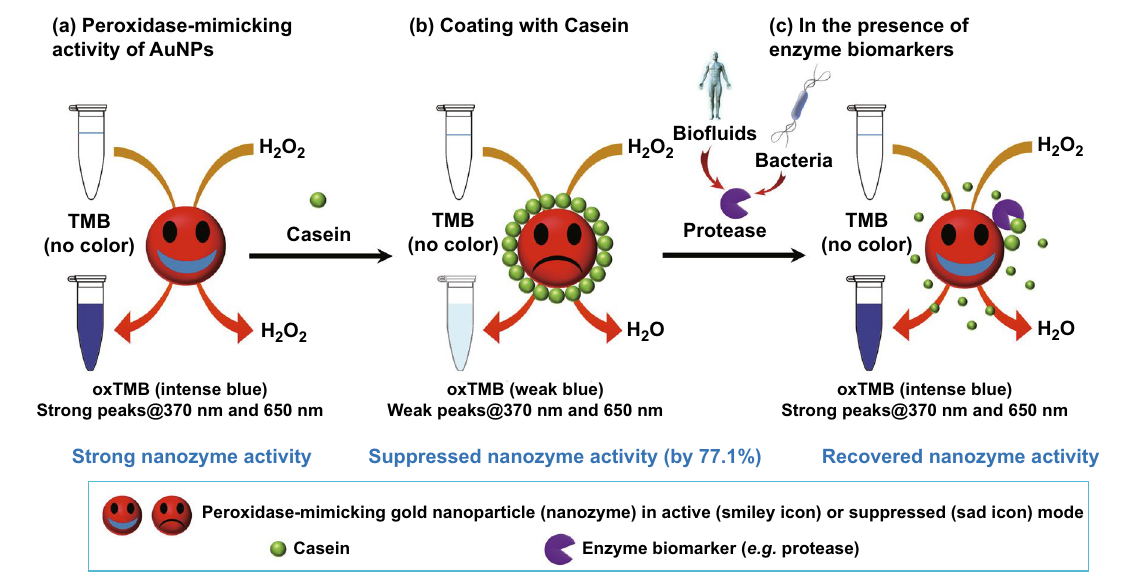
Fig. 12 Colourimetric sensor using gold nanozymes for the detection of proteolytic biomarkers indicative of food spoilage or human disease [102]. Copyright 2018 McVey et